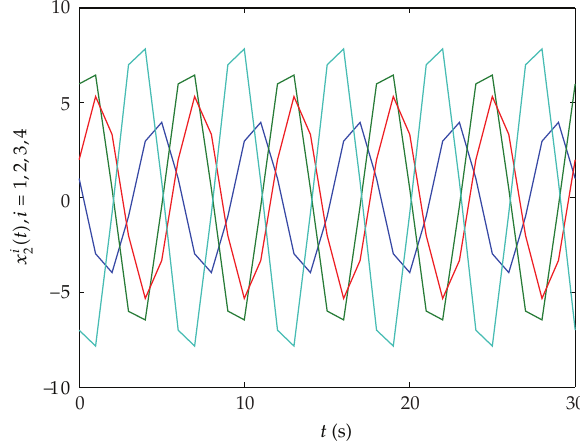
Figure 2: The time histories of x i